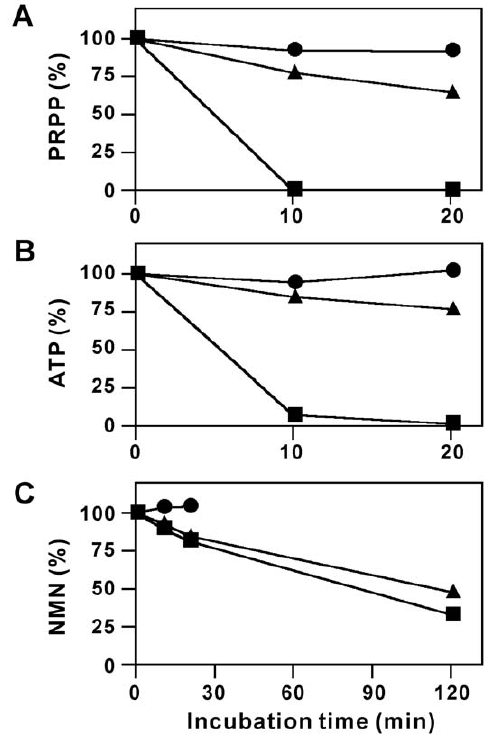
Figure 3. PRPP, ATP, and NMN are degraded in mouse blood plasma. PRPP, ATP, or NMN (150, 300, or 60 pmol, respectively) was incubated with the blood plasma (30 m l) in the presence of EDTA/EGTA at 4 ( circles ) or 37 u C ( triangles ) or in the absence of the chelators at 37 u C ( squares ) for the indicated times. After the incubation, the amounts of PRPP (A), ATP (B), and NMN (C) remaining at each time point in the plasma were determined and expressed as percent of those at 0 min.